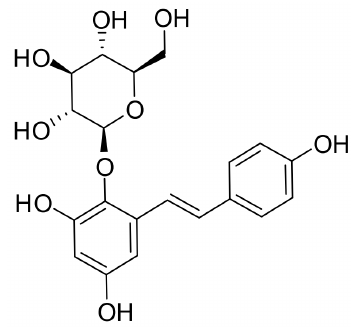
Figure 1. Chemical structural formula of tetrahydroxystilbene glucoside (TSG)